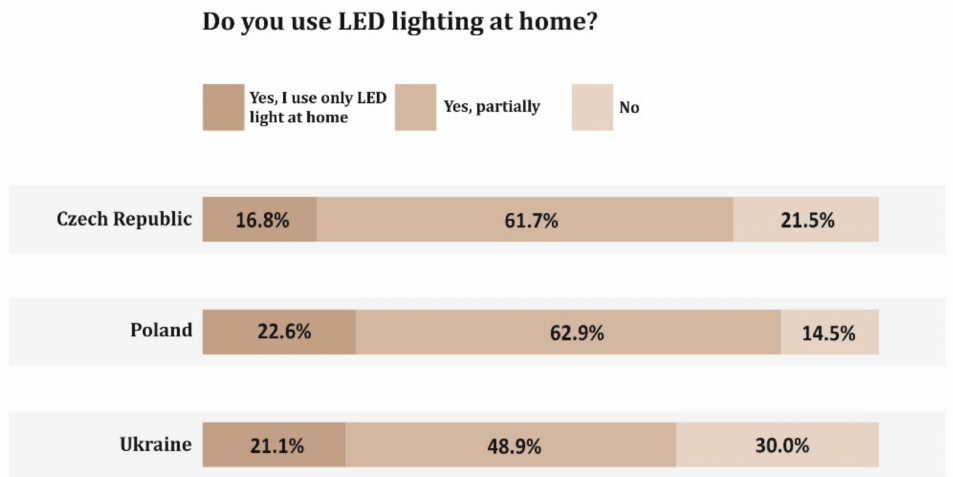
Figure 7. The use of LED lighting by the surveyed students. Source: own